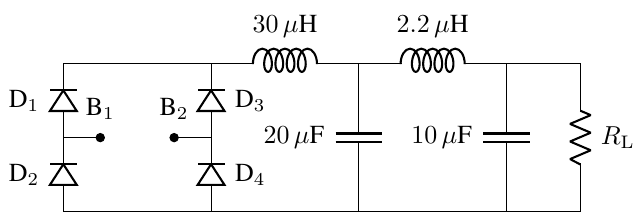
Fig. 3. Circuit diagram for rectifier, filter and load